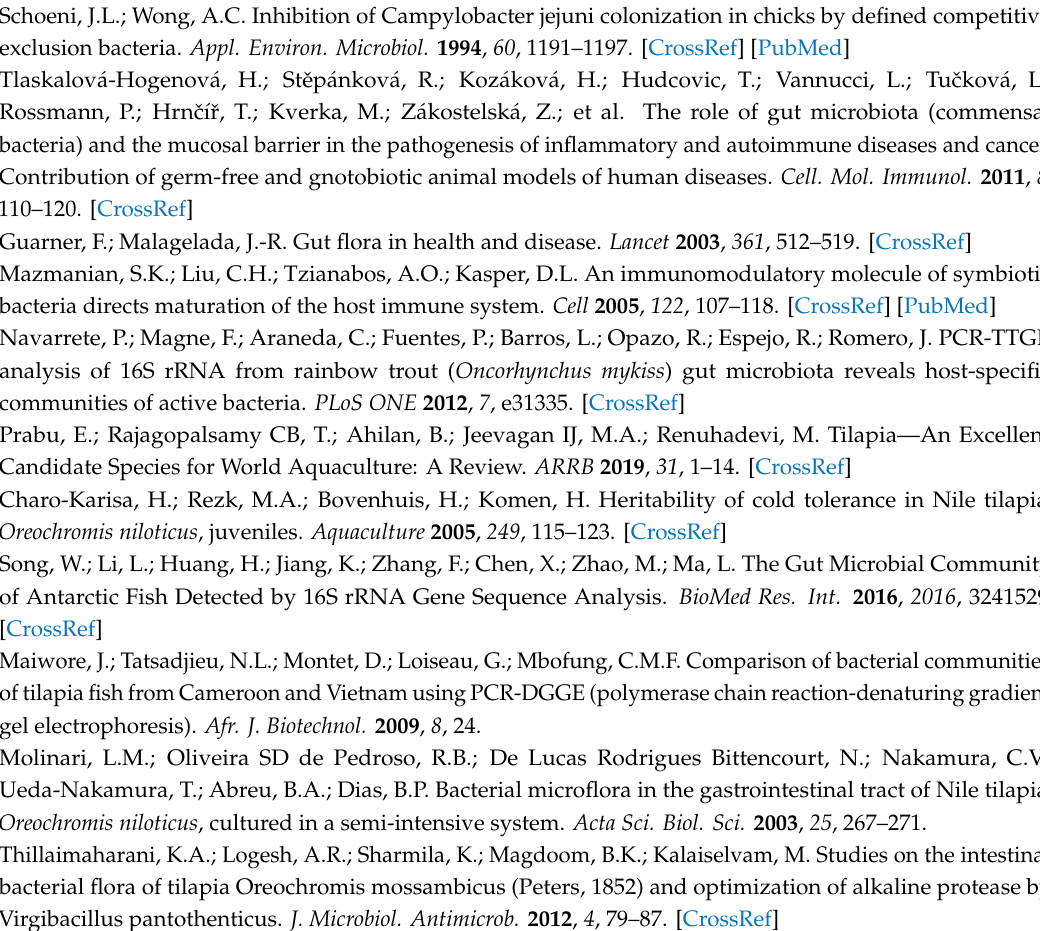
Figure S1: Di ff erential abundance analysis of some phyla. Figure S2: Principal coordinate analysis (PCoA) plot of all samples between intestinal content and mucosa. Each dot represents one sample. Figure S3: Rarefaction curve, Table S1: Bacterial genus significantly di ff erent between lake Awassa and Chamo. Table S2: Bacterial genus significantly di ff erent between the gut regions. Table S3: Goods